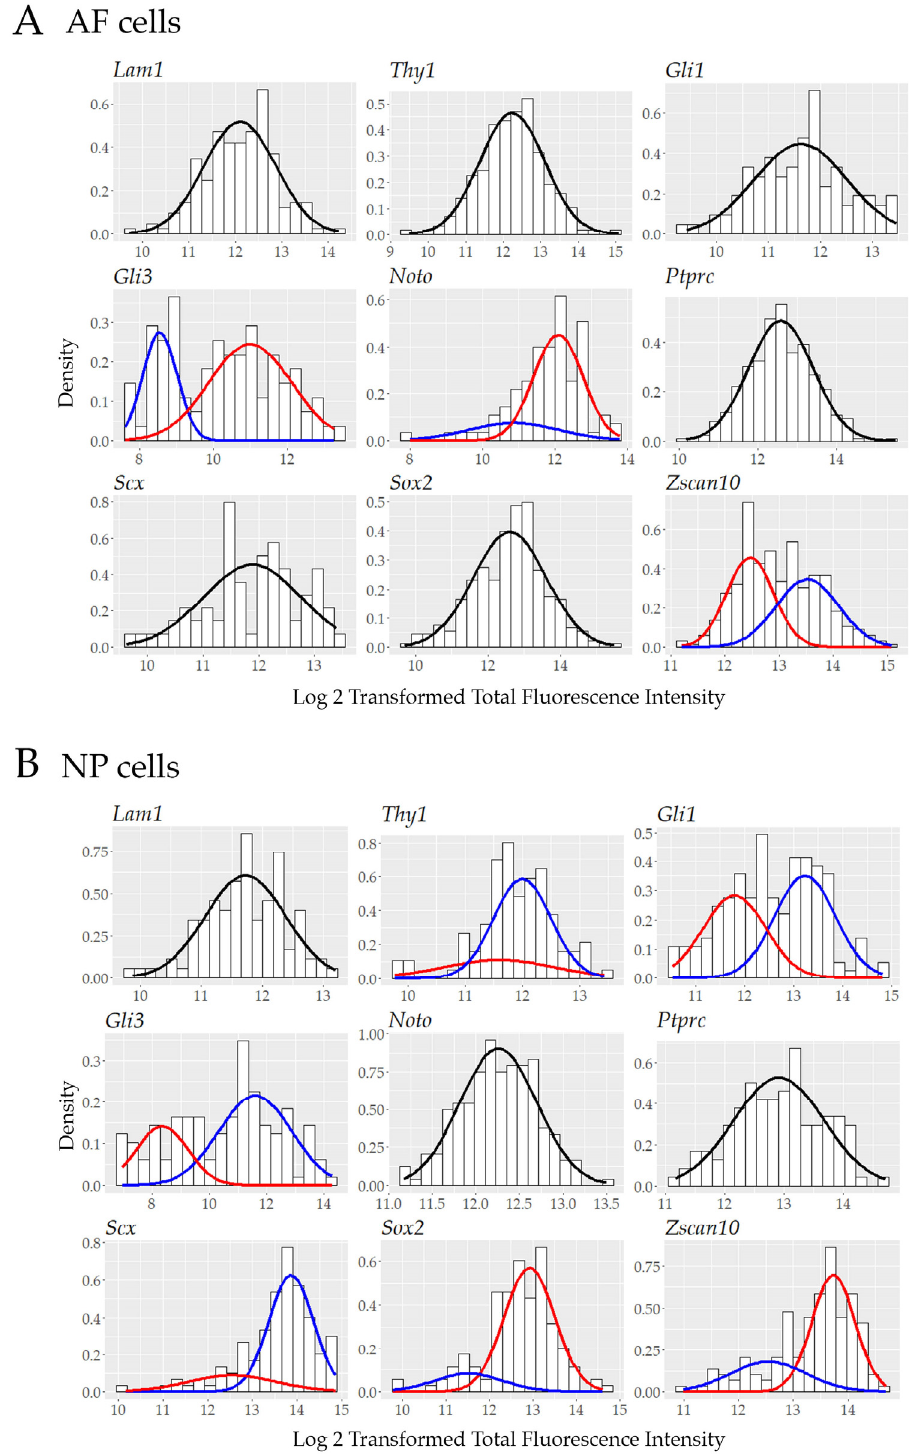
Figure 6. Gaussian mixture model and histograms of data for nine proposed biomarkers in ( A ) cells of the outer AF and ( B ) NP of a mature bovine IVD fitted to one or two Gaussian distributions using the expectation-maximization algorithm depending on the normality of the data. Laminin1 ( Lam1 ); Thymocyte differentiation antigen 1 ( Thy1 ); Glioma-associated oncogene 1 ( Gli1 ); Glioma-associated oncogene 3 ( Gli3 ); Notochord ( Noto ); Tyrosine phosphate receptor type C ( Ptprc ); Scleraxis ( Scx ); Sex determining region Y-box 2 ( Sox2 ); Zinc finger and SCAN ( SRE-ZBP, CTfin51, AW-1 and Number 18 cDNA) domain containing transcription factor 10 ( Zscan10 )